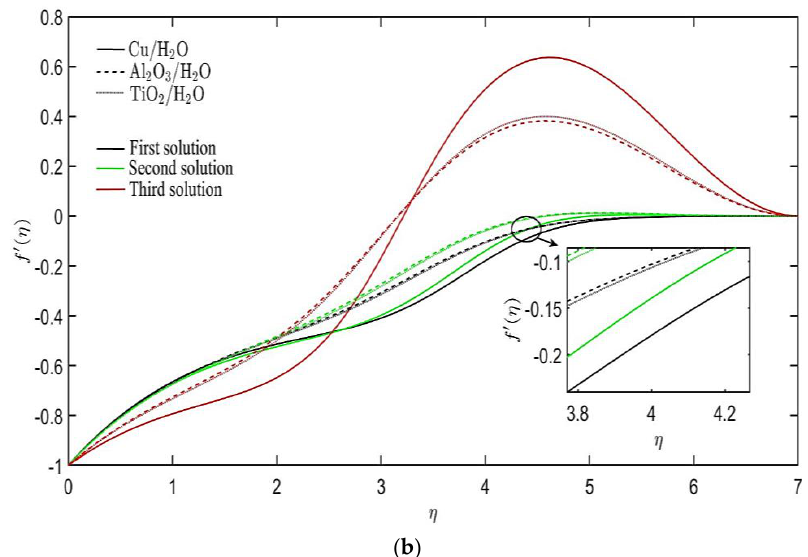
Mathematics 2022 , 10 , x FOR PEER REVIEW Figure 2. Velocity profiles of different nanofluids for: ( a ) Stretching case; ( b ) Shrinking case.